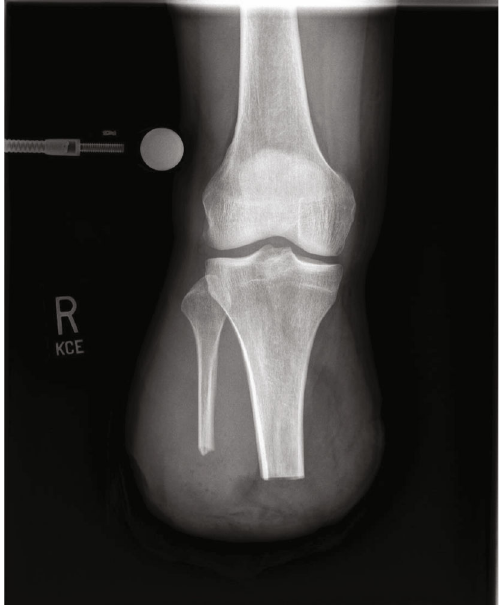
Figure 4: Anteroposterior radiograph of the right knee fourteen days postoperatively showing transtibial BKA.